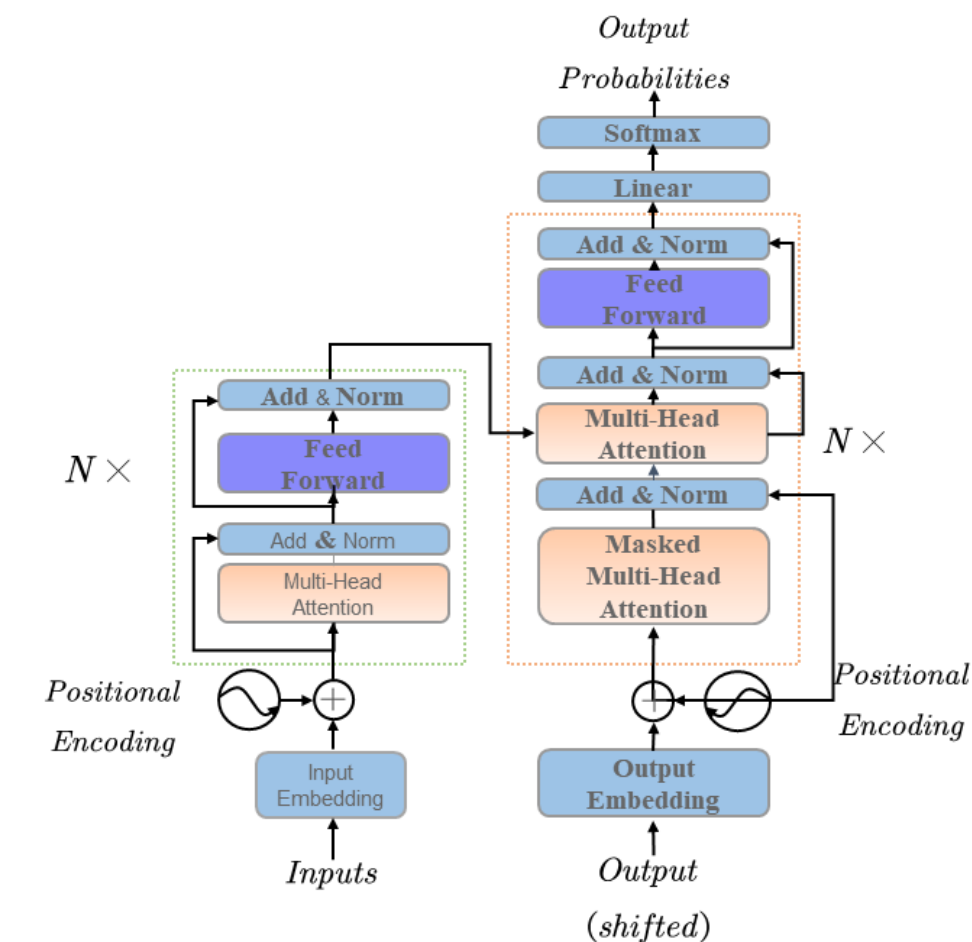
Figure 1. Flowchart of the structure of the standard